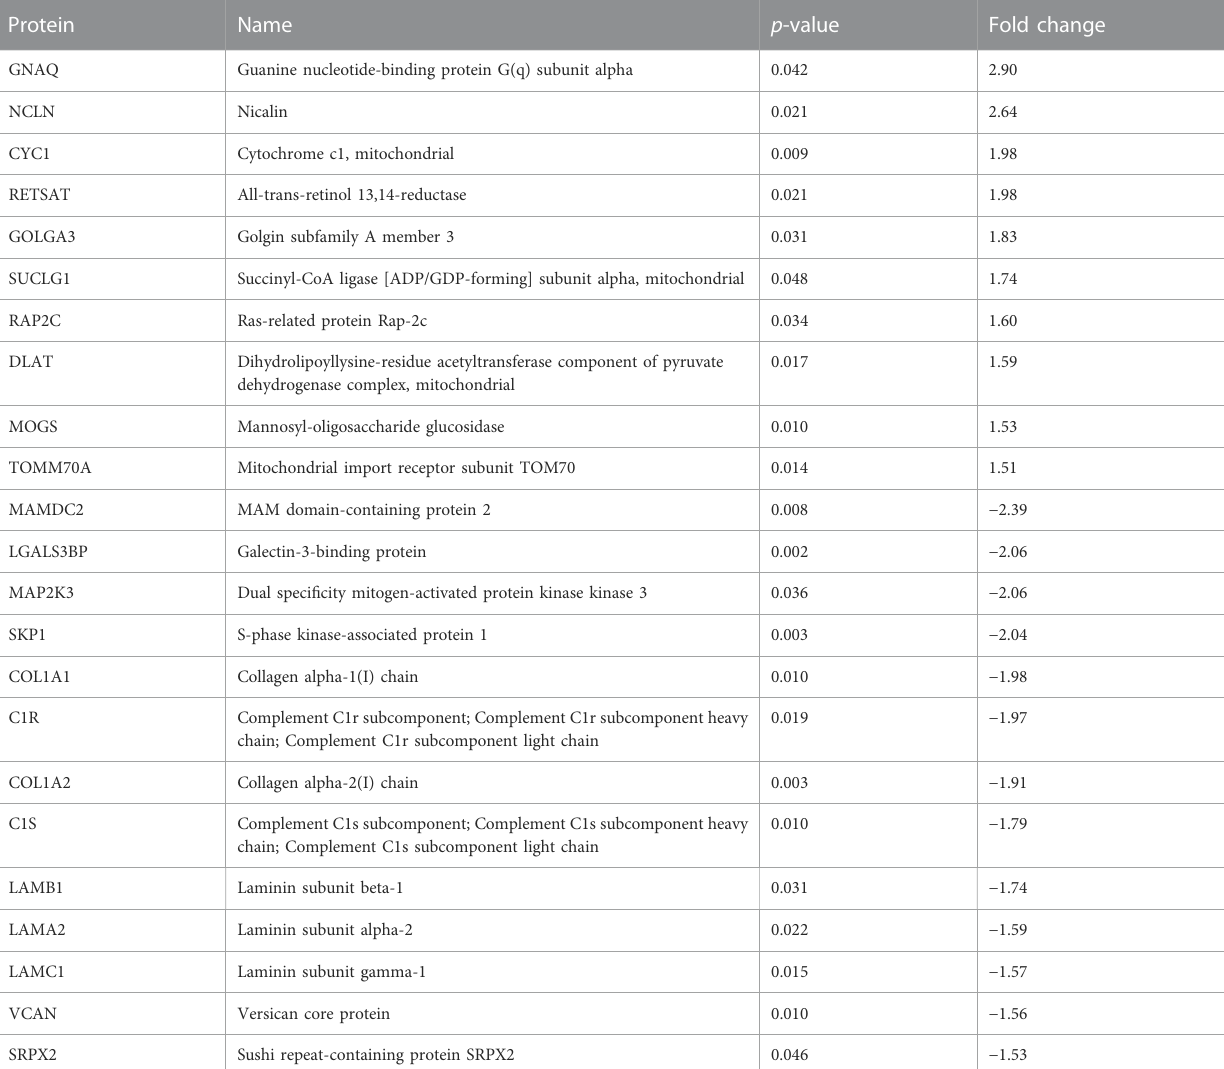
TABLE 3 The MV proteins that were most ( > 1.5-fold) changed by EPS.